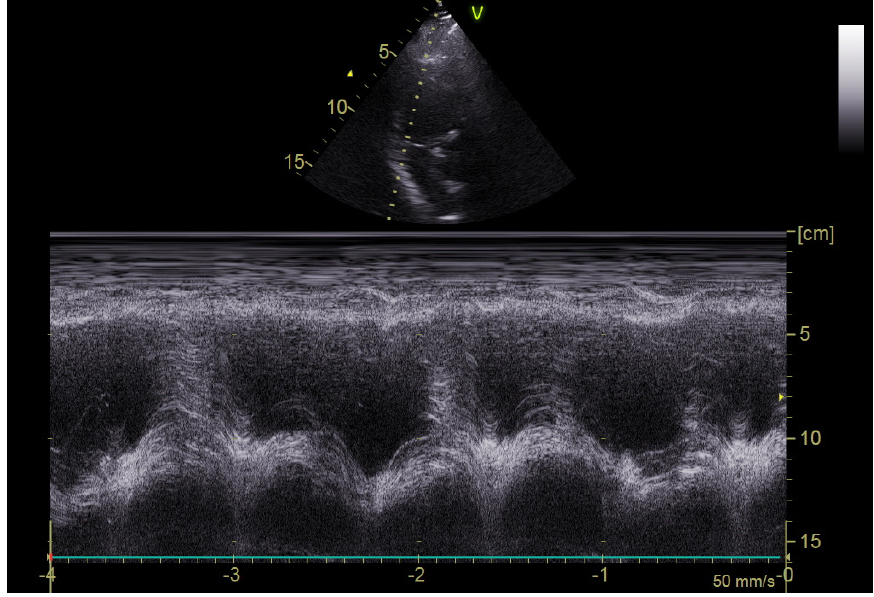
Figure 3. M mode of TAPSE of the free right ventricular wall as seen from the right-ventricle-focused apical view.